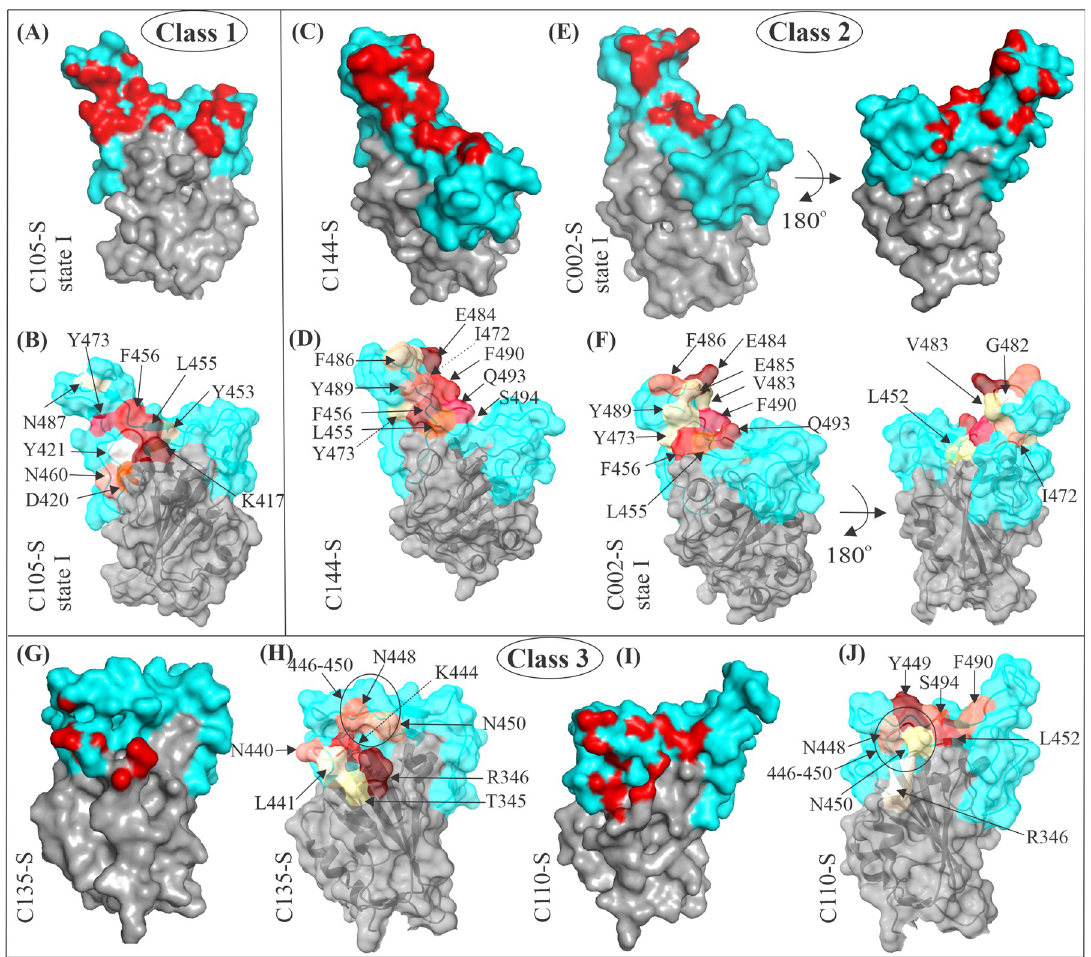
Fig 5. SARS-CoV-2 RBD mutations that escape antibody binding. Total escape at each site was measured using a yeast library screening followed by deep sequencing for distinct RBD antibodies (https://jbloomlab.github.io/SARS2_RBD_Ab_escape_maps/). The escape map identifies mutations that escape antibody binding and were mapped on the RBD-Fab structures. The red indicates the site with maximum and white with minimum resistance for antibody binding. (A, C, E, G, I) The structural footprint of C105, C144, C002, C135, and C110 antibodies on the RBM is in red. (B, D, F, H, J) Mapping of the SARS-CoV-2 virus escapes for different antibodies. Mutations that escape antibody binding were broadly located at their binding site in the RBD (see A-B, C-D, E-F, G-H, and I-J pairs). The footprint residues on the RBD have been defined as those residues, which were within 4 Å of a Fab atom. RBD, receptor-binding domain; SARS-CoV-2, Severe Acute Respiratory Syndrome Coronavirus